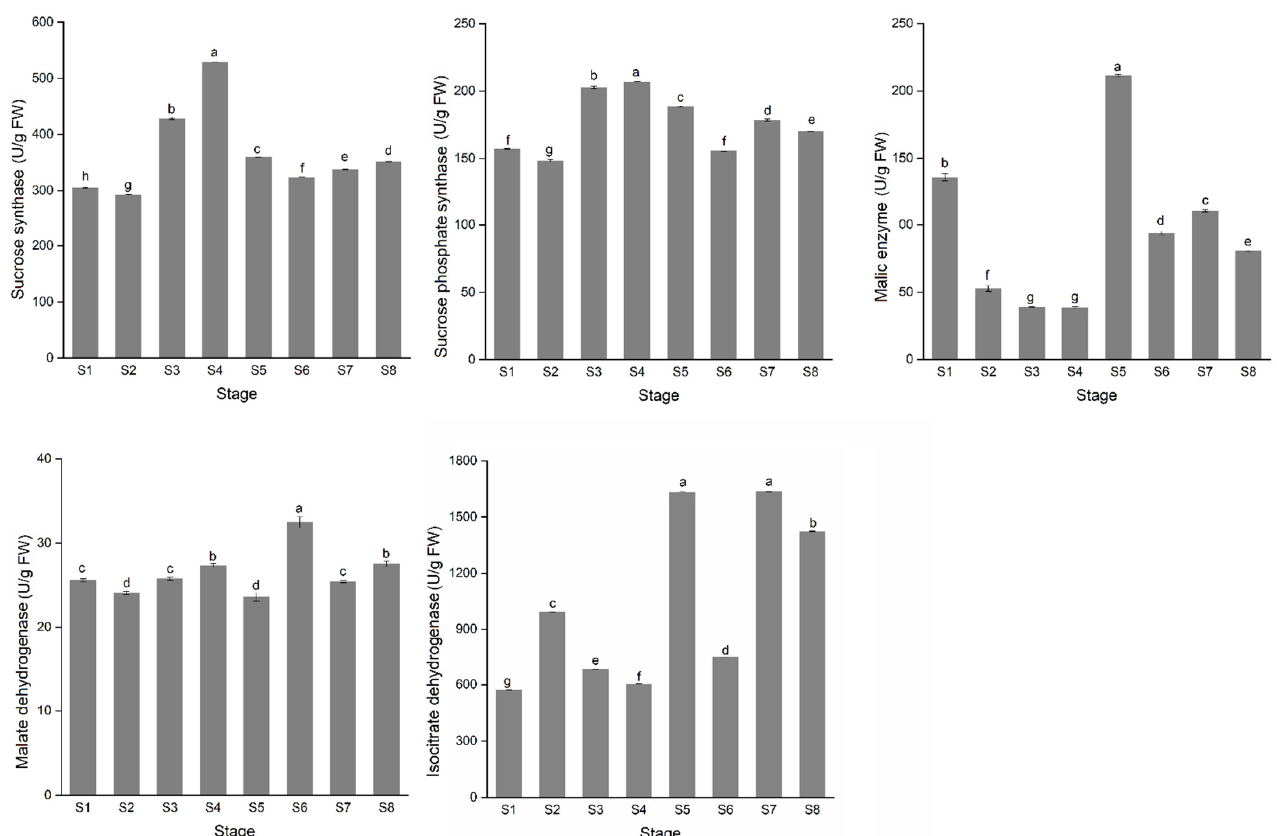
Figure 3. Changes in the activity of sugar and acid-related enzymes at different expansion stages of the stem. Vertical bars with different letters (a–e) indicate significant differences at the 0.05 level. Three biological replicates were performed for each index.